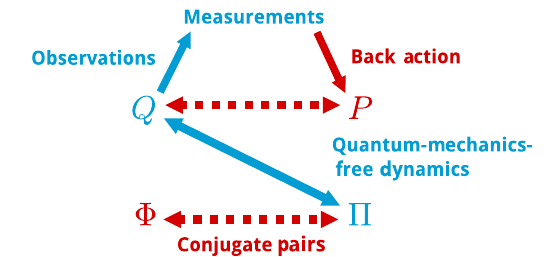
FIG. 1. A quantum-mechanics-free subsystem (QMFS, in blue), which consists of dynamically coupled quantum- nondemolition (QND) observables f Q; (cid:2) g . The QMFS naturally evades measurement back-action; measurements of Q , for example, produce backaction onto the conjugate observable P , which does not influence the QMFS observables Q and (cid:2)